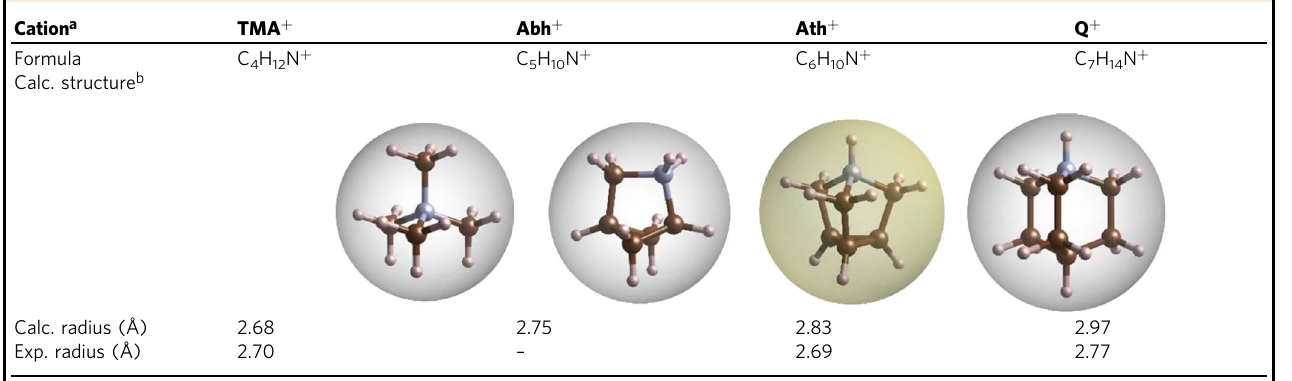
Table 1 Structure and size of several spheroidal organic ammonium ions. Cation